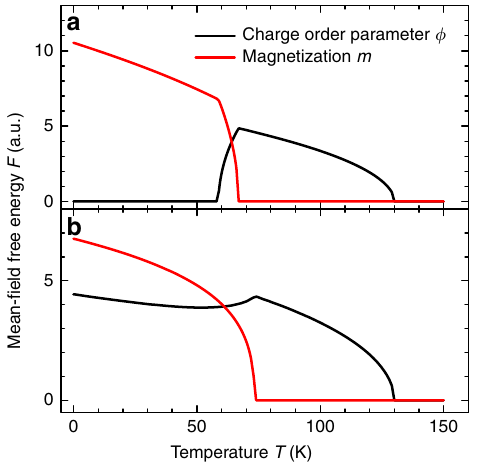
Figure 4 | Expansion of the temperature-dependent GL free energy. Plots showing the results of an expansion of the GL free energy F to the fourth (( a ) parameters: a ¼ 0.9, a 0 ¼ 1, T P ¼ 130, T C 0 ¼ 100, b ¼ 2.4, b 0 ¼ 0.9, g ¼ 1.4, c ¼ c 0 ¼ 0) and to the sixth power (( b ) same parameters, except for c ¼ c 0 ¼ 0.015), as described in equations (1) and (2),